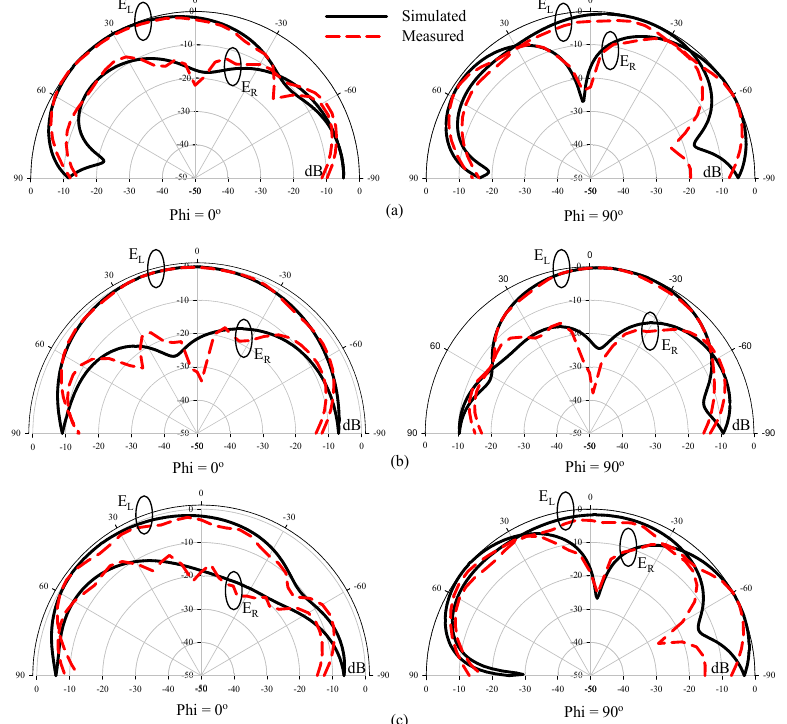
Figure 14. Simulated and measured S 11 and AR overlapping bandwidths of the CP 5G RDRA. The simulated and measured radiation patterns of the proposed CP 5G RDRA are presented in Figure 15. The radiation patterns were computed and measured at three different frequencies. The antenna provided stable radiation patterns with left-hand circular polarization, since the left-hand field component was greater than the right-hand field component by a margin of more than 20 dB at minimum AR frequency i.e., 4.43 GHz, as shown in Figure 15b. The right-hand CP response could be achieved by reversing the feeding strip. The simulated and measured gain of the CP antenna are shown in Figure 16. The antenna offers a useful gain of ~6.2 dBic throughout the CP bandwidth. This high gain was achieved by excitation of the higher-order mode. A reasonable resemblance was observed between simulated and measured results.